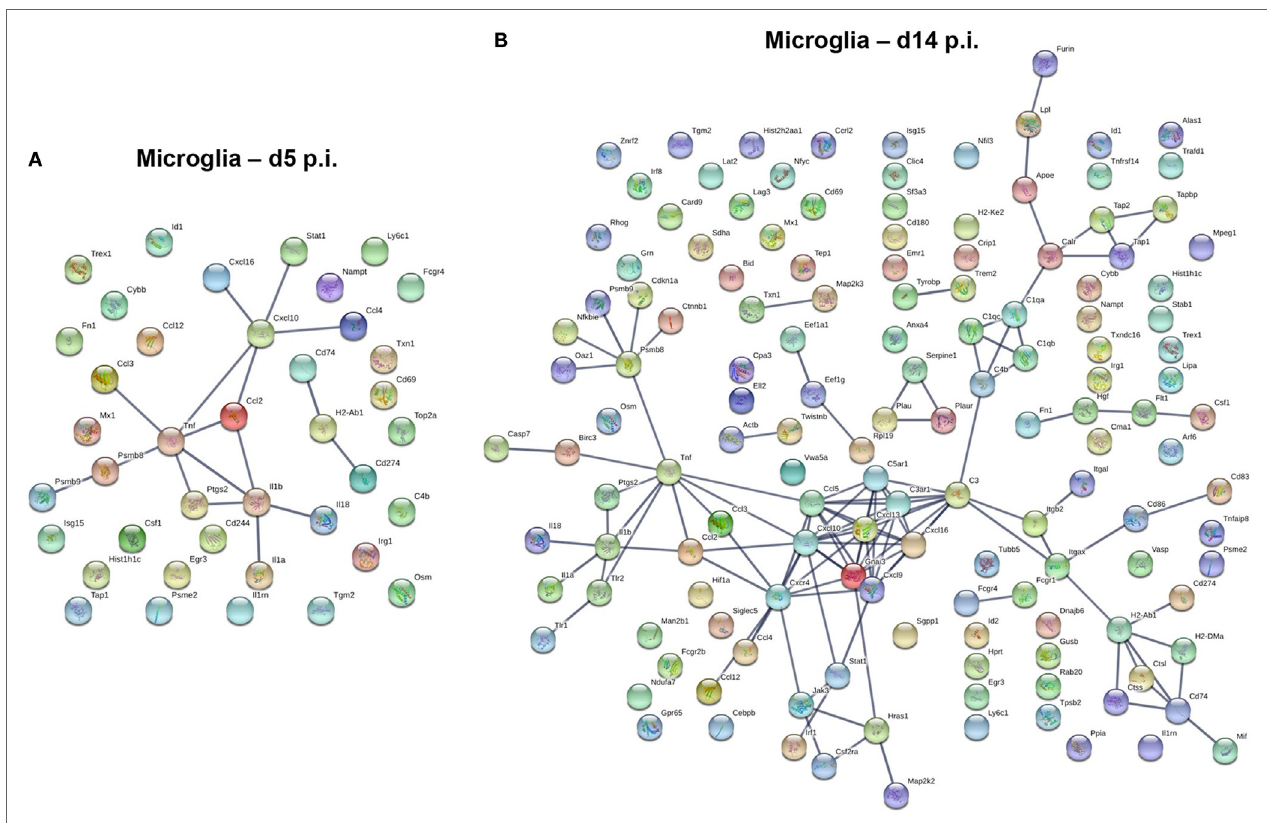
FigUre 7 | Upregulated gene network within microglia at d5 p.i. and peak demyelination. Protein–protein network constructed based on microglia genes upregulated by at least twofold at days 5 (a) and 14 (B) p.i. compared to naïve levels were analyzed using Ingenuity IPA